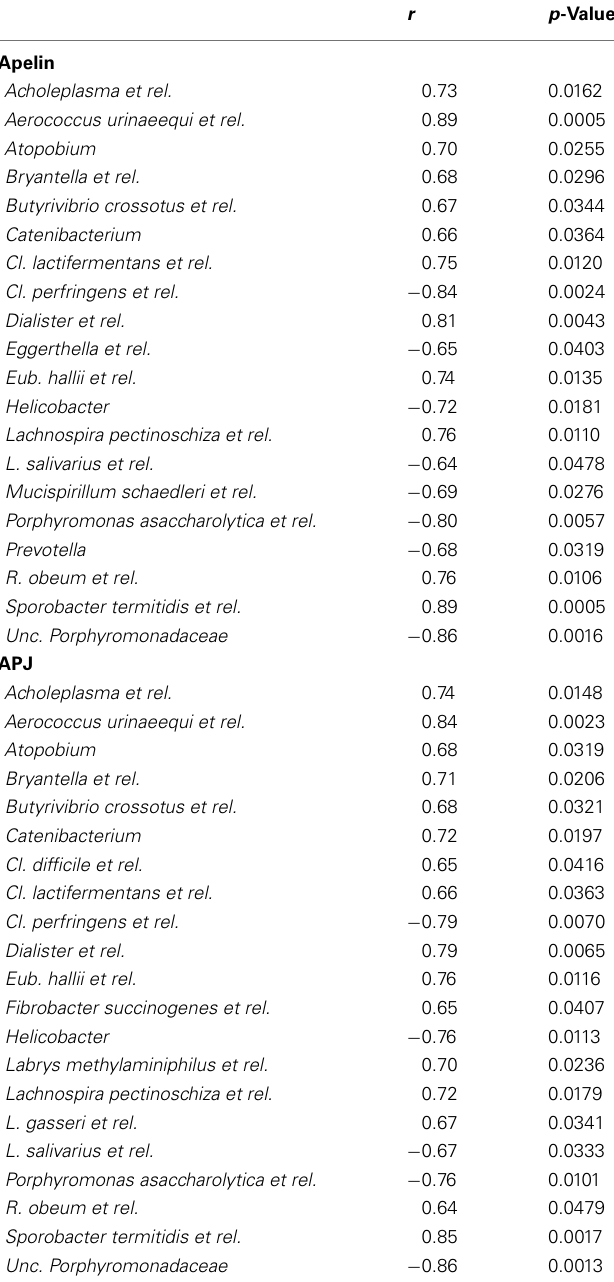
Table 2 | Correlations between changes in the abundance of specific bacteria and adipose tissue apelin orAPJ mRNA levels.